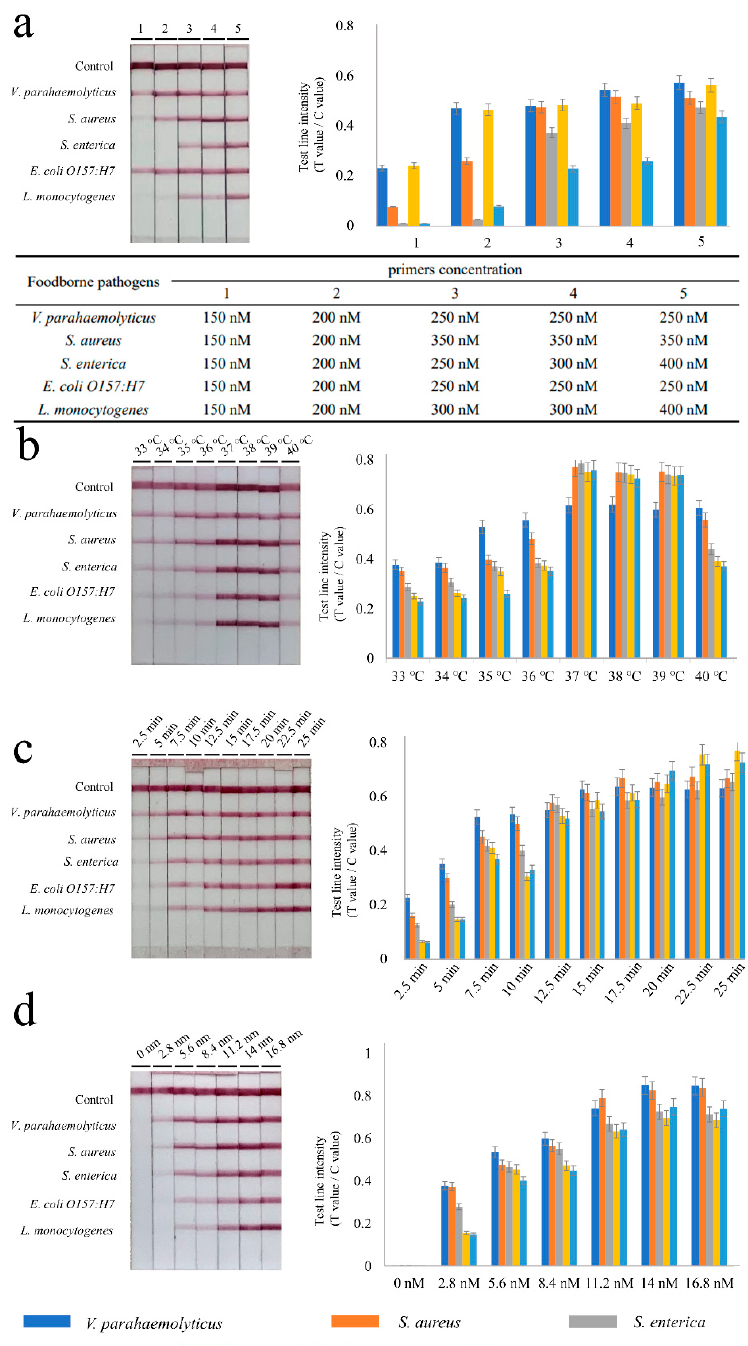
Figure 2. Optimization of recombinase polymerase amplification reactions. ( a ) Different primer concentrations and the corresponding primer concentrations are shown in the three-line table. ( b ) The results for the incubation temperature, ( c ) the results for the RPA reaction time, ( d ) the results for the magnesium ions concentration. The RPA products were detected using lateral flow immunoassay (LFIA) based on labeled colloidal gold (presented in left). The intensity of reflected light signal from the T-line and C-line on LFIA was obtained by the test strip reader. The test line intensity is defined as the ratio of the T value and the C value. The bar graph is based on the radio of different T-lines and C-line (presented on the right). Each parameter is shown on the top of the strips or in the bottom of the bar graph. Three replicates are shown in the